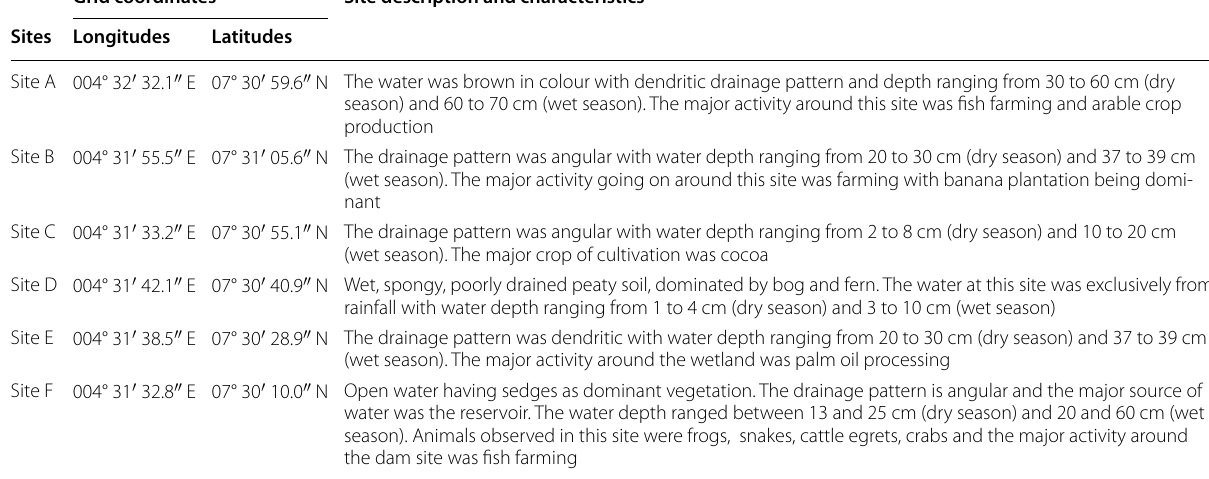
Table 1 The coordinates and characteristics and site description of the sampled location Grid coordinates Site description and characteristics Sites Longitudes